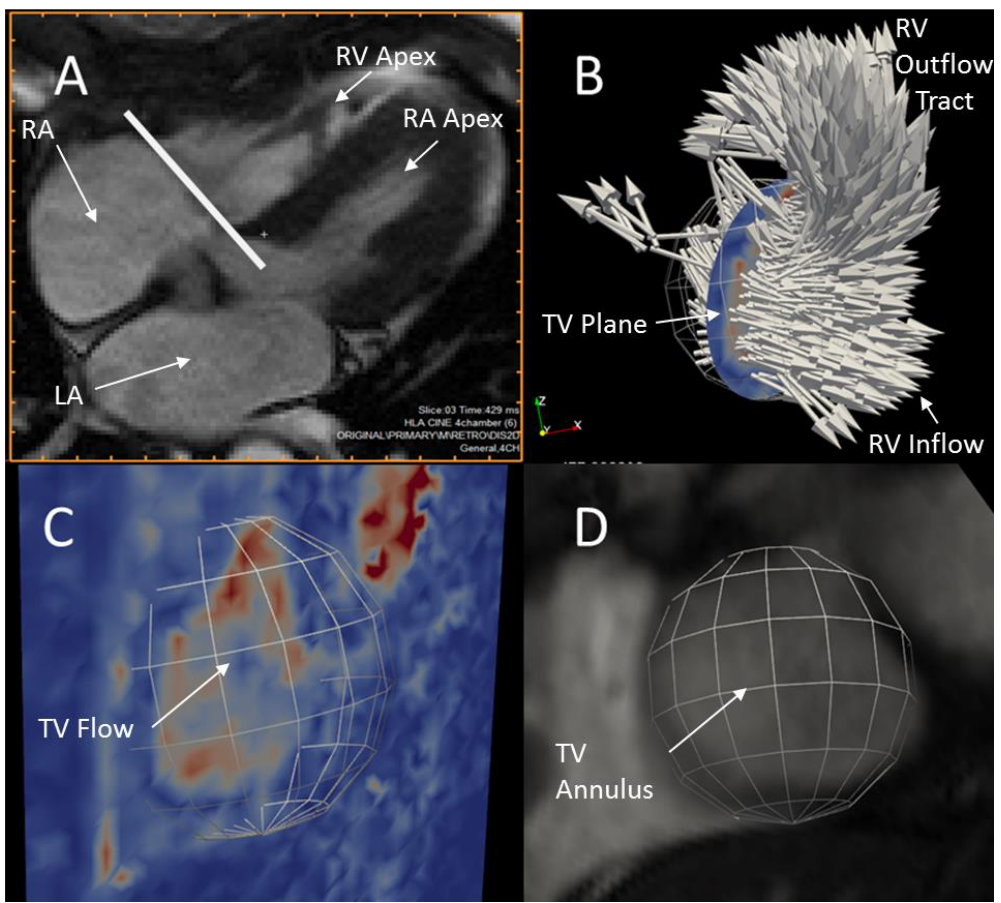
Figure 4. Available data used to locate the diastolic tricuspid valve (TV) plane and circular area. ( A ) 4-chamber cine tissue contrast image at early diastole with a line denoting the TV plane; ( B ) Velocity vectors at early diastole in the region of the tricuspid valve showing the disk location; ( C ) a plane colored by velocity magnitude at early diastole showing the spherical clip used to produce the disk; ( D ) A short-axis tissue contrast cine image showing the TV blood pool at early diastole.